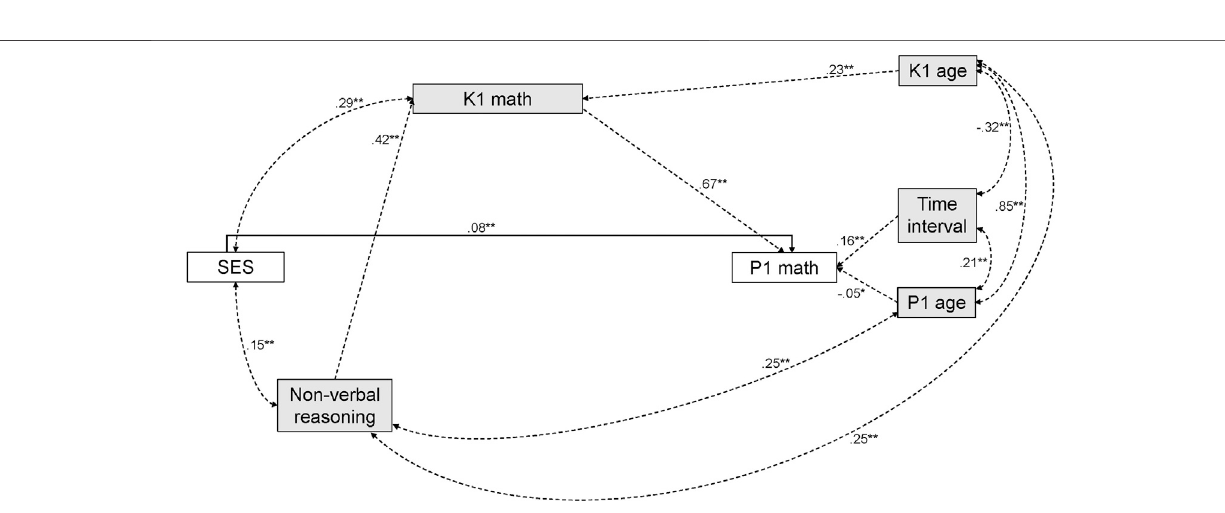
Frontiers in Education |